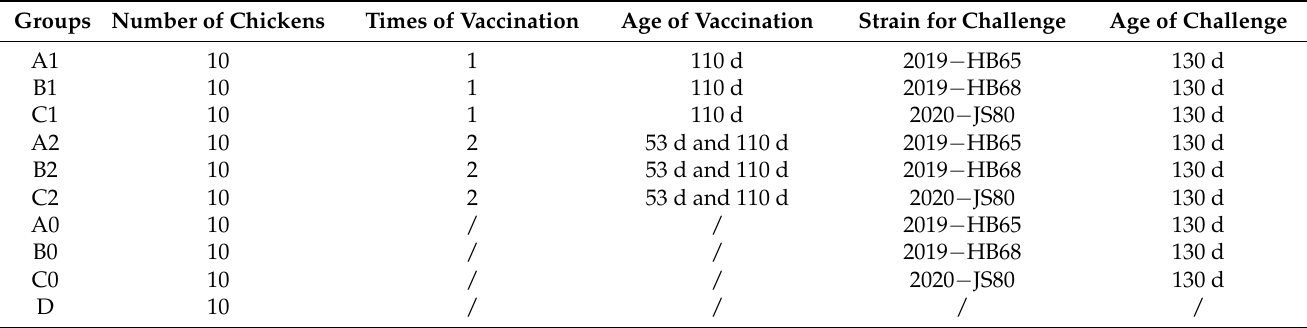
Table 1. Immunization procedure and challenge experiments